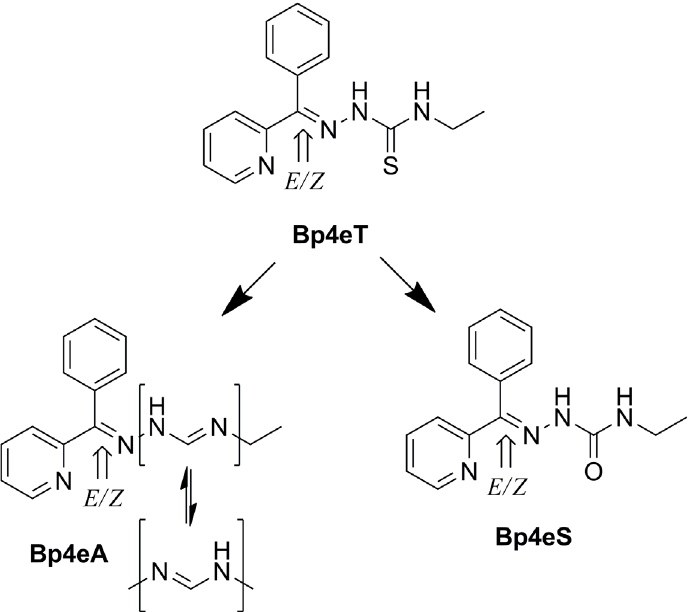
Fig 1. Line drawings of the structures of Bp4eT and its metabolites and indication of E/Z isomerism. Bp4eT, 2-benzoylpyridine 4-ethyl-3-thiosemicarbazone; Bp4eA; N 3 -ethyl- N 1 -[phenyl(pyridine-2yl)methylene] formamidrazone; Bp4eS, 2-benzoylpyridine 4-ethylsemicarbazone.